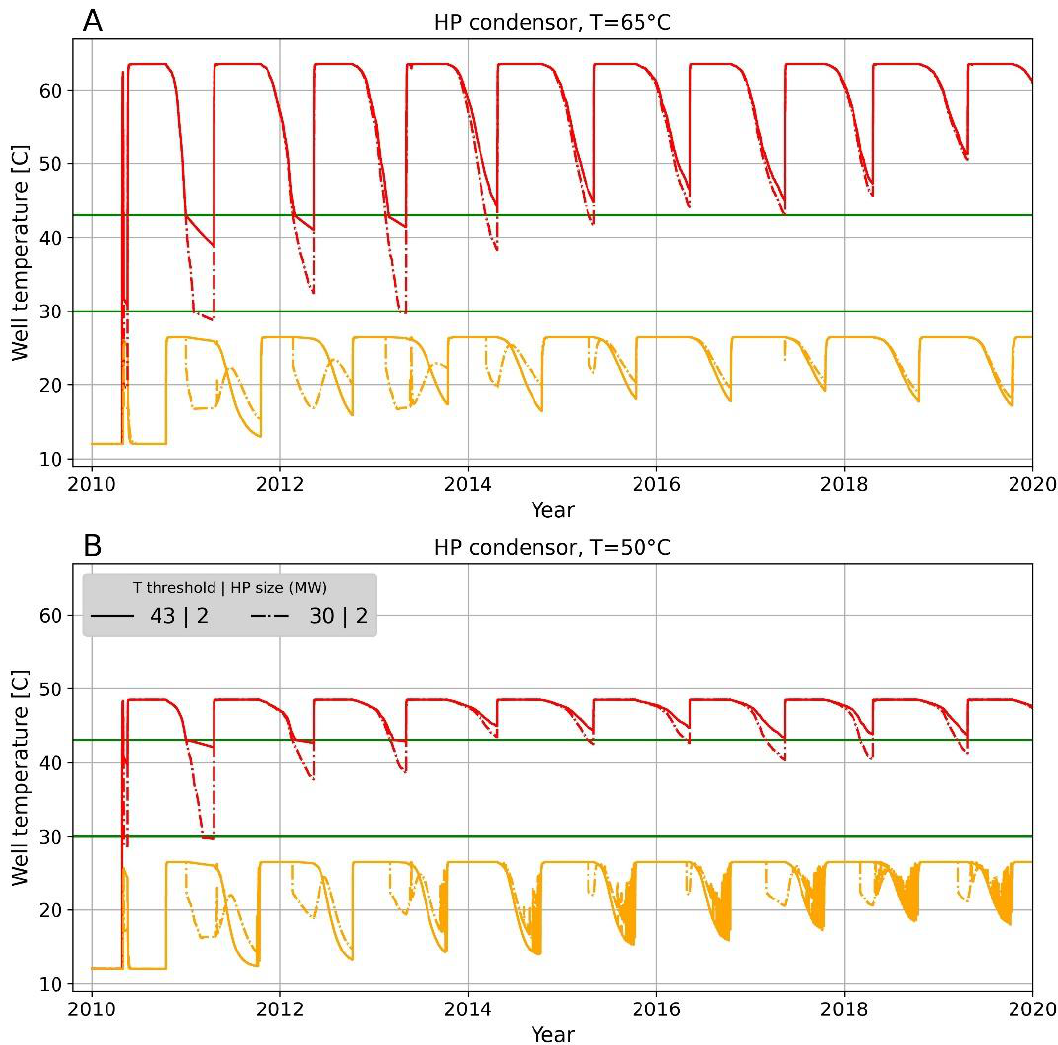
Figure 6. Overview of the temperature variations of the hot well and warm well for a 65 ◦ C condenser temperature ( A ) and 50 ◦ C condenser temperature ( B ). Scenarios with a 2 MW el heat pump are shown, both with (65|30|2 or 50|30|2) and without (65|43|2 and 50|43|2) the HT-ATES feeds heat pump mode. The green lines show the threshold temperatures at 43 ◦ C and 30 ◦ C (with the HT-ATES feeds heat pump mode). With the HT-ATES feeds heat pump mode (threshold temperature of 30 ◦ C), a sharp drop in the temperature of the warm well is visible when the 43 ◦ C threshold temperature in the hot well is reached. The HT-ATES feeds heat pump mode is utilized mostly during the first four years of operation at the 65 ◦ C condenser temperature and during most of the run period at the 50 ◦ C condenser temperature. The legend in ( B ) is valid for ( A ) as well.